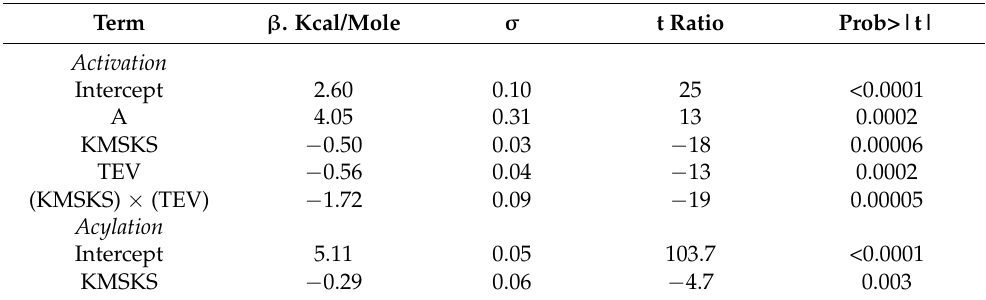
Table 3. Summary data for comparing catalytic activities of WT LeuAC and the triple lysine mutant. Amino acid activation was assayed by active-site titration. tRNA Leu aminoacylation was assayed with 1.6 µ M LeuAC and 3 µ M active tRNA Leu . Tables show regression coefficients, β . In kcal/mole for the dependence of the respective activation free energies ( ∆ G ‡ k chem for activation; ∆ G ‡ obs rate for acylation) on changes in the respective independent variables, together with their t -test p -values. β . Kcal/Mole